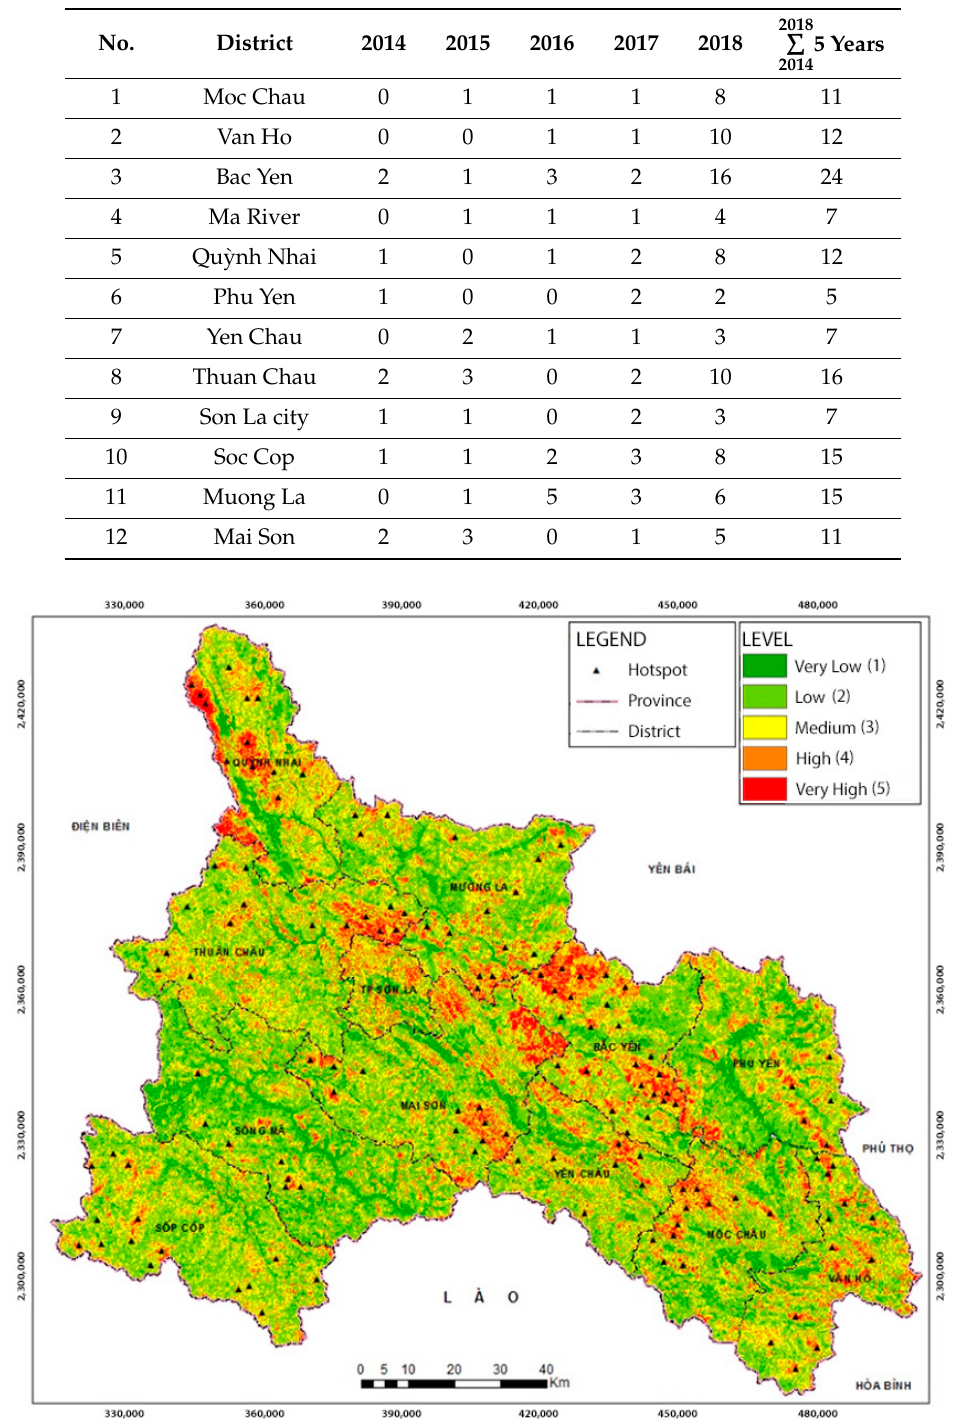
Figure 8. Map of fires in Son La Province from 2014 to 2018, based on forest fire risk maps. (Source: Son La Province). Table 5. Historical forest fires from 2014 to 2018 in Son La Province.